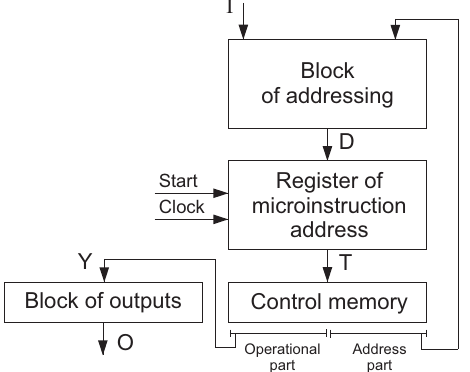
Figure 6. Three-level microprogram control